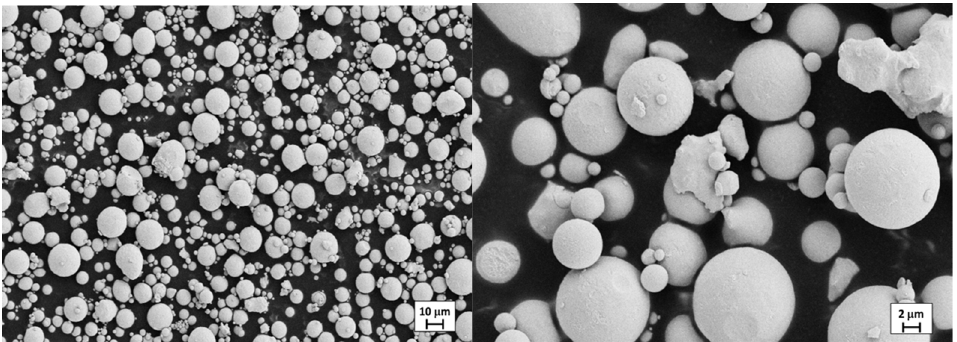
Figure 3. Powders morphology of CuSn12 alloy, SEM images.